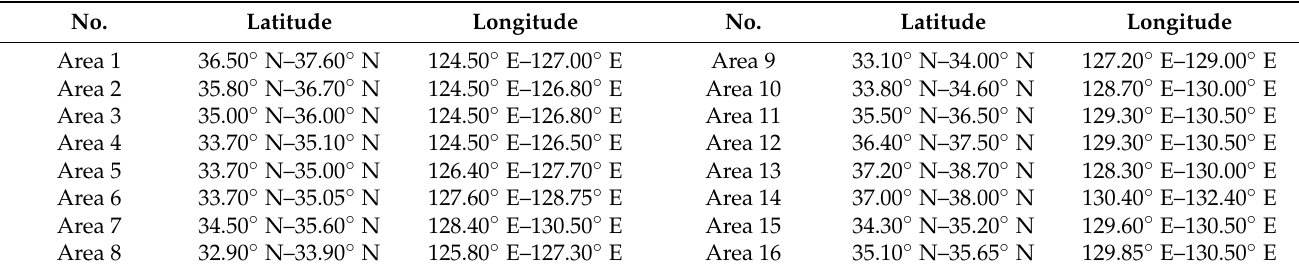
Table 1. Coordinate system of the analysis area.